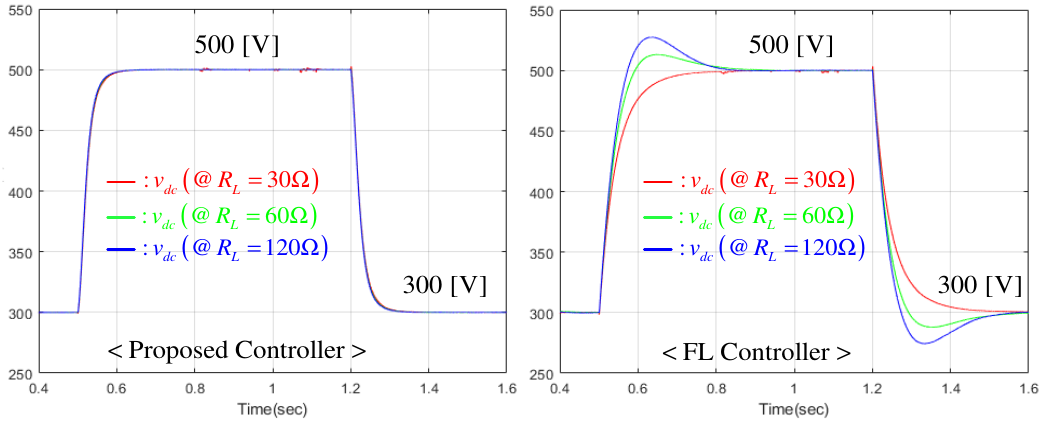
Figure 3. DC-link voltage tracking behavior changes for three loads, R L = 30,60,120 Ω .